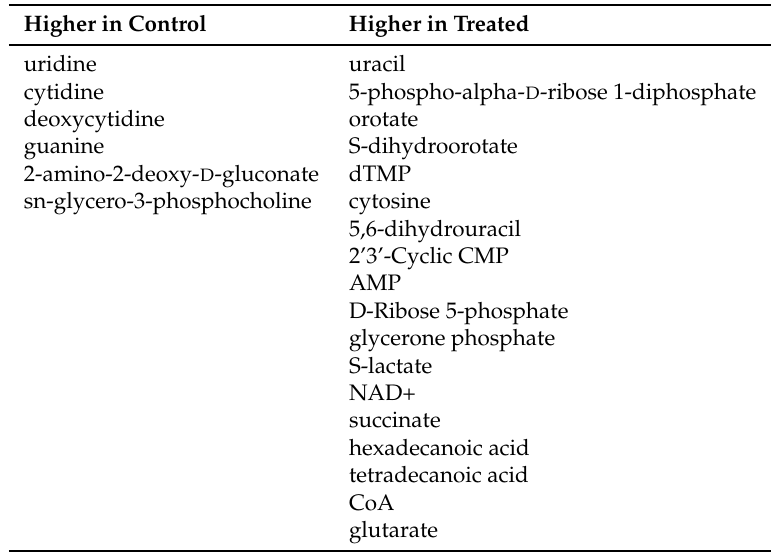
Table 8. McDonnell 2013, metabolite set.